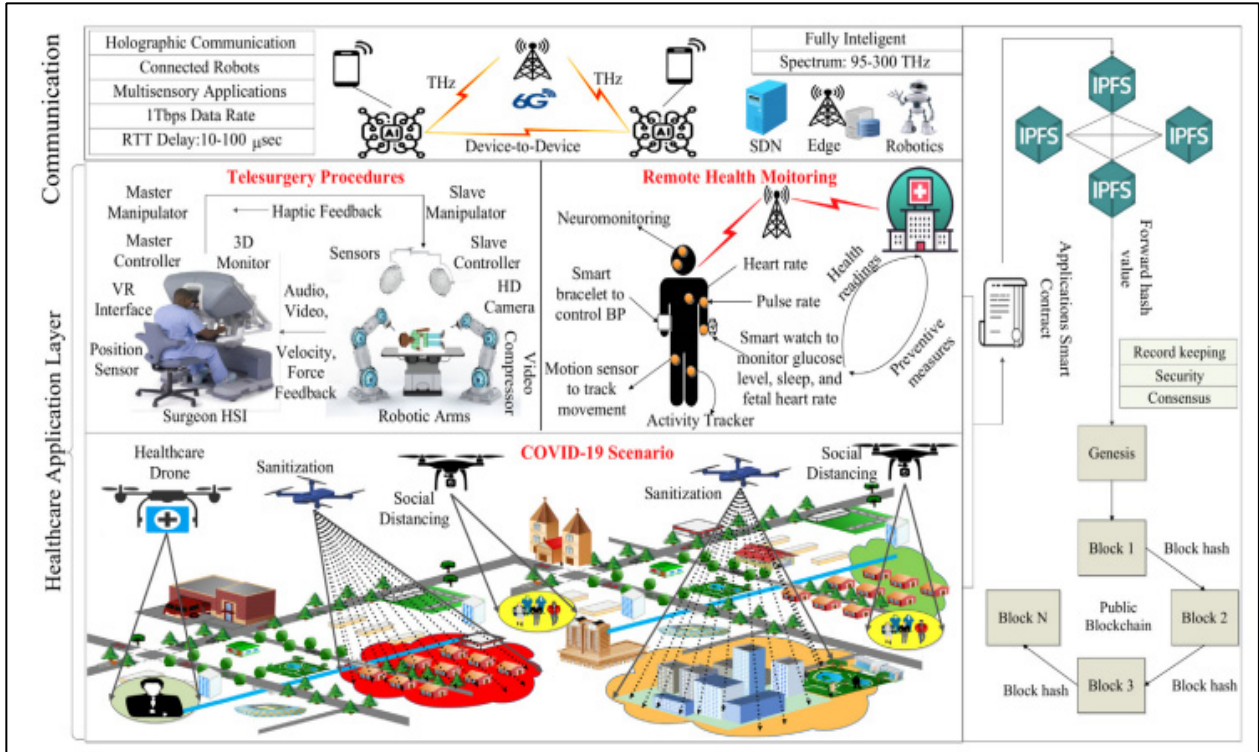
Figure 2. Blockchain-based 6G environment [11]. Table 1. AMSTAR